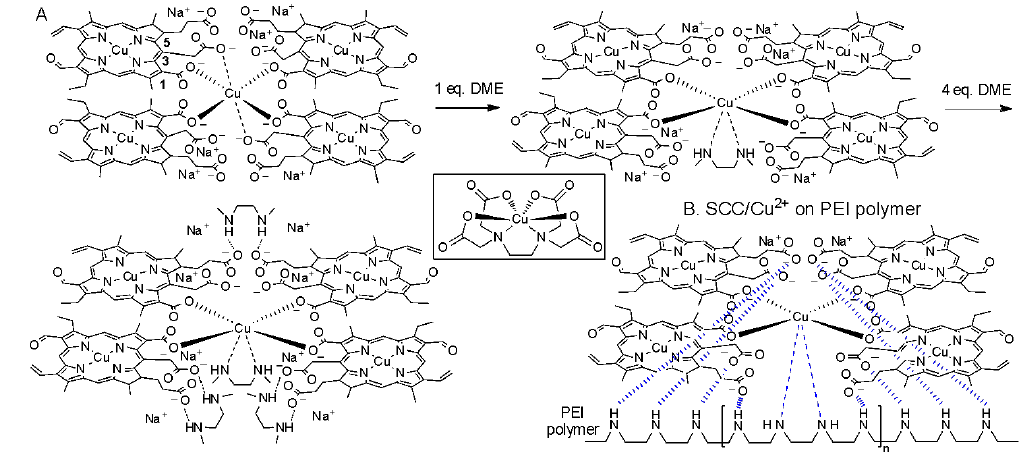
one-site binding fitting function. c Raw data obtained from titration of SCC (84.3 μM) and Cu 2+ (28.1